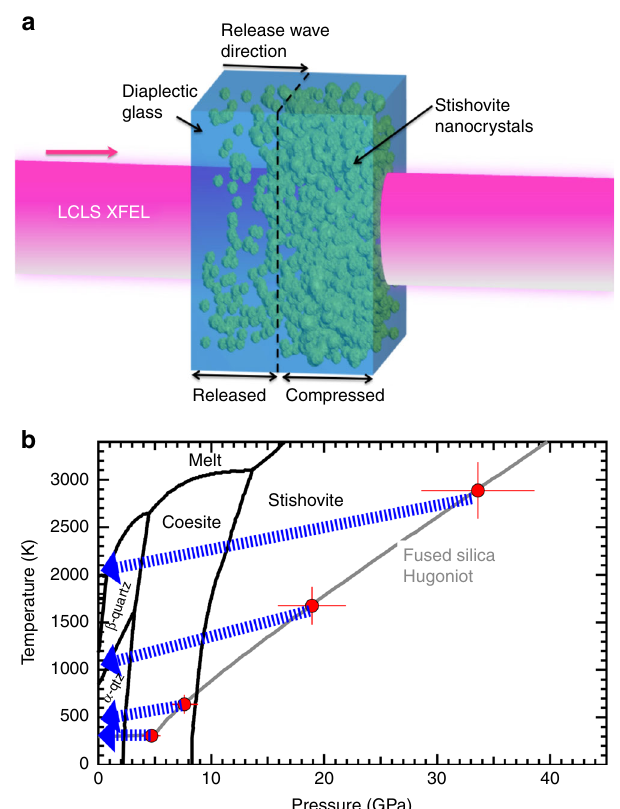
Fig. 1 Experimental con fi guration and explored phase space. a Target schematic for sample during the shock-release process. During the onset of release, newly formed grains of stishovite (green sphere-like features) dissolve over a few nanoseconds leaving behind diaplectic glass. b Equilibrium phase diagram 32 of SiO 2 showing high-pressure polymorphic phase boundaries and melt curve (black). The fused silica Hugoniot (gray) using data 18,33,34 . Red points are maximum pressure, temperature conditions achieved for particular ablation drive laser parameters as determined from velocimetry records. The error bars include scatter in the measured transit times, uncertainty in the total sample thickness, uncertainty in the pressure-irradiance scaling law 18 . Isentropic release paths (blue arrows, determined using Sekine et al. 35 ) show the approximate conditions achieved in this experiment at late time delays, e.g., 12 – 30 ns (i.e., during release), and release shock temperatures are determined